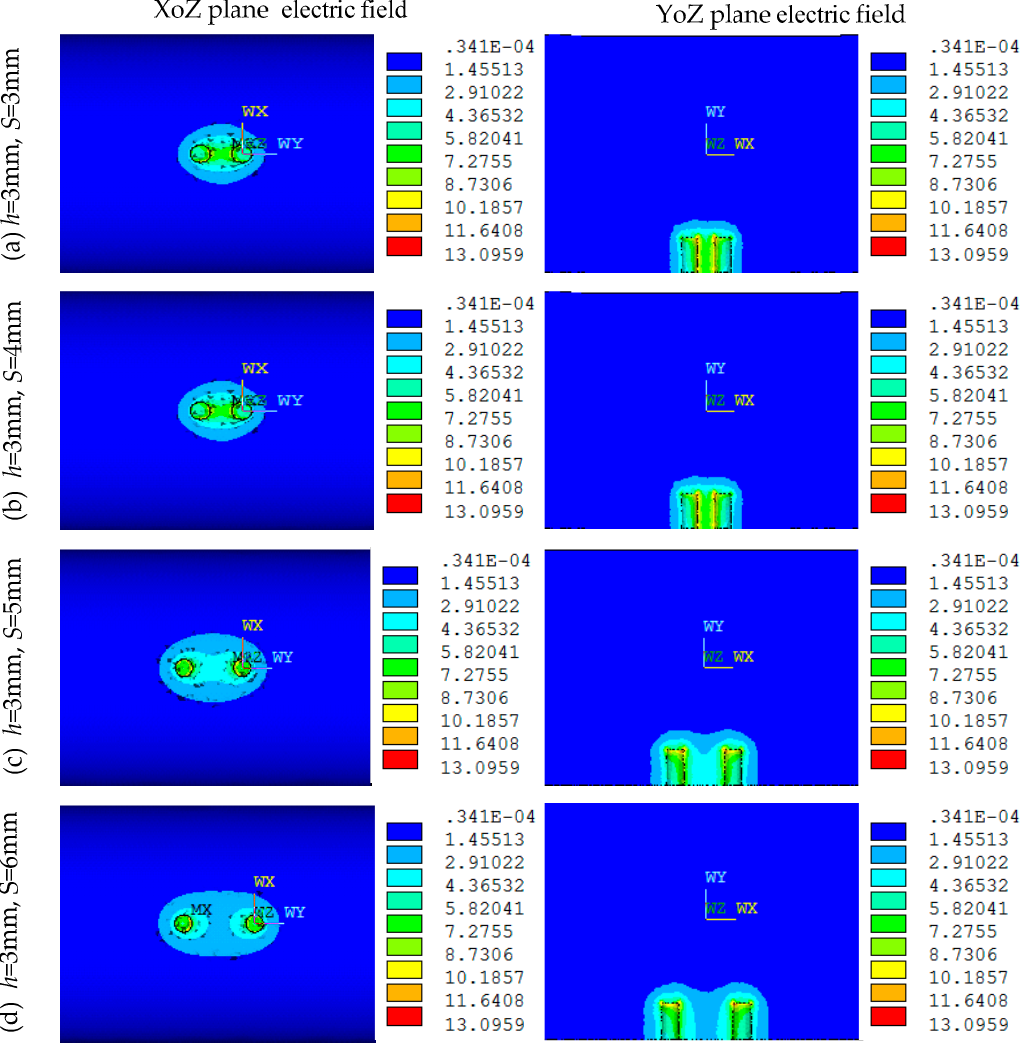
Figure 3. Electric field distribution of the MCP under different S values ( D = 20 mm, h = 3 mm, d = 1.5 mm): ( a ) S = 3 mm; ( b ) S = 4 mm; ( c ) S = 5 mm; ( d ) S = 6 mm.